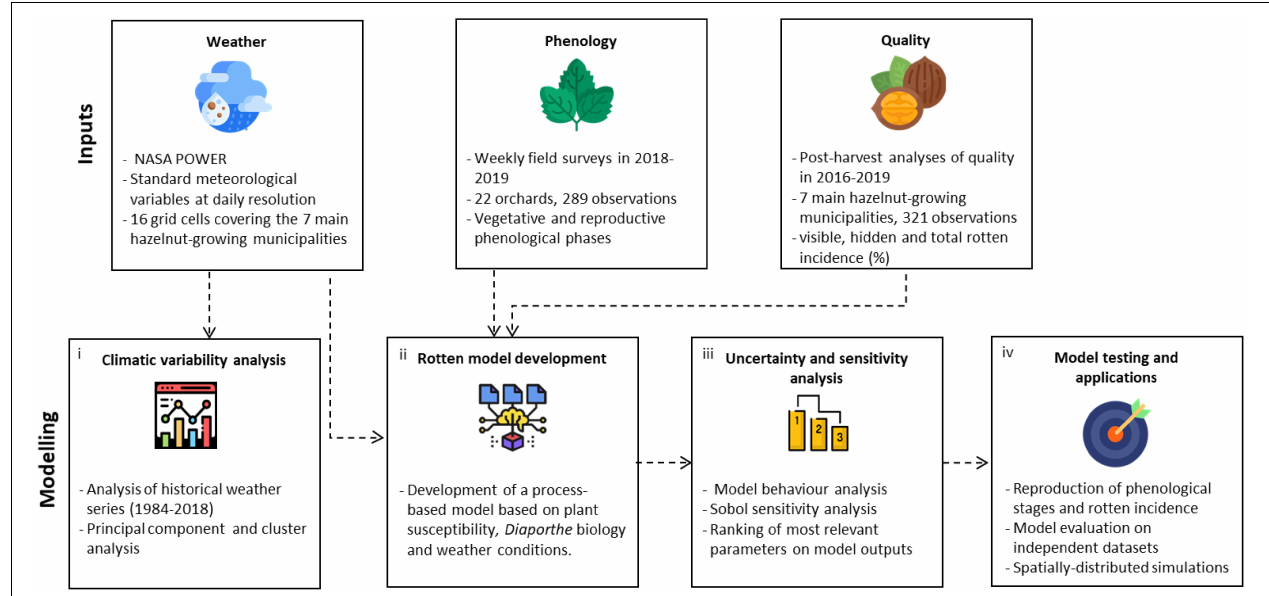
FIGURE 1 | Workflow of the study. Input data sources (weather data, phenological observations, and rotten incidence data) were used (i) to perform a climatic characterization of the study area, (ii) to develop a process-based simulation model of rotten hazelnuts, which was then subjected to (iii) an uncertainty and sensitivity analysis to understand the model behavior across climatic conditions. Finally, (iv) the model was calibrated and evaluated using field data and applied over the Turkish hazelnut